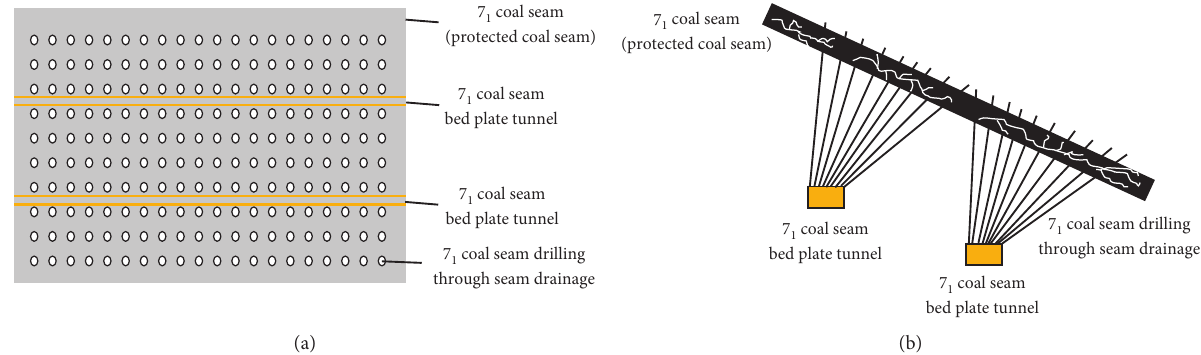
Figure 7: Borehole pattern in protected coal seam 7 1 . (a) Plan view of borehole pattern in protected coal seam 7 1 . (b) Cross-sectional view of borehole drilling.